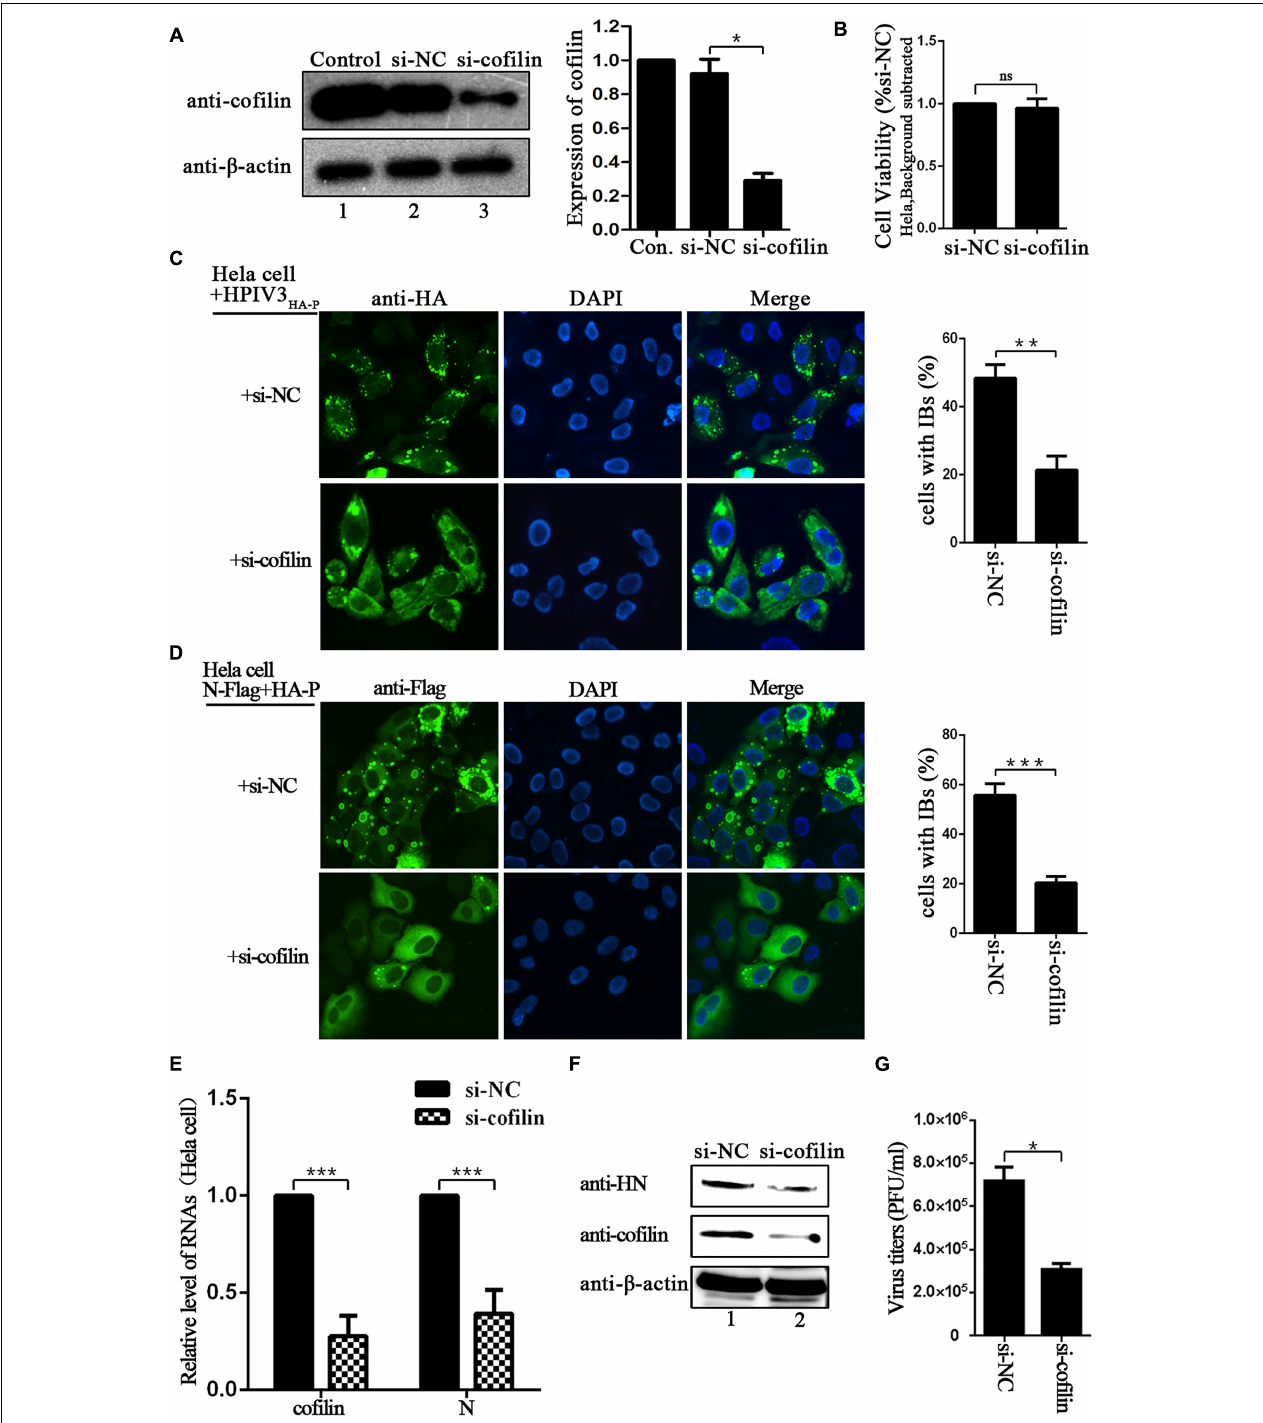
FIGURE 3 | Depletion of cofilin affects IBs formation and RNA synthesis in Hela cells. (A) Hela cells were mock transfected or transfected with si-NC control or si-cofilin targeting cellular cofilin. Expression level of cofilin was analyzed by WB. Cellular β -actin was used as a loading control. Data are means ± SD from three experiments. Student’s test: ∗ p < 0.05. (B) Hela cells transfected with si-NC or si-cofilin for 24 h, and the cell viability was examined by CCK8 assay as the manufacture’s instruction. The viability of cell was not significantly influenced by cofilin depletion. Data are means ± SD from three experiments. Student’s test: ns, non-significant. (C) Hela cells were transfected with si-NC or si-cofilin, and infected with HPIV3 HA - P at an MOI of 1 after 24 h transfection. At 24 h postinfection, the cells were fixed, HA-P was immunostained to visualize IBs and nuclei were counterstained with DAPI. The percentage of cells containing IBs were quantified,